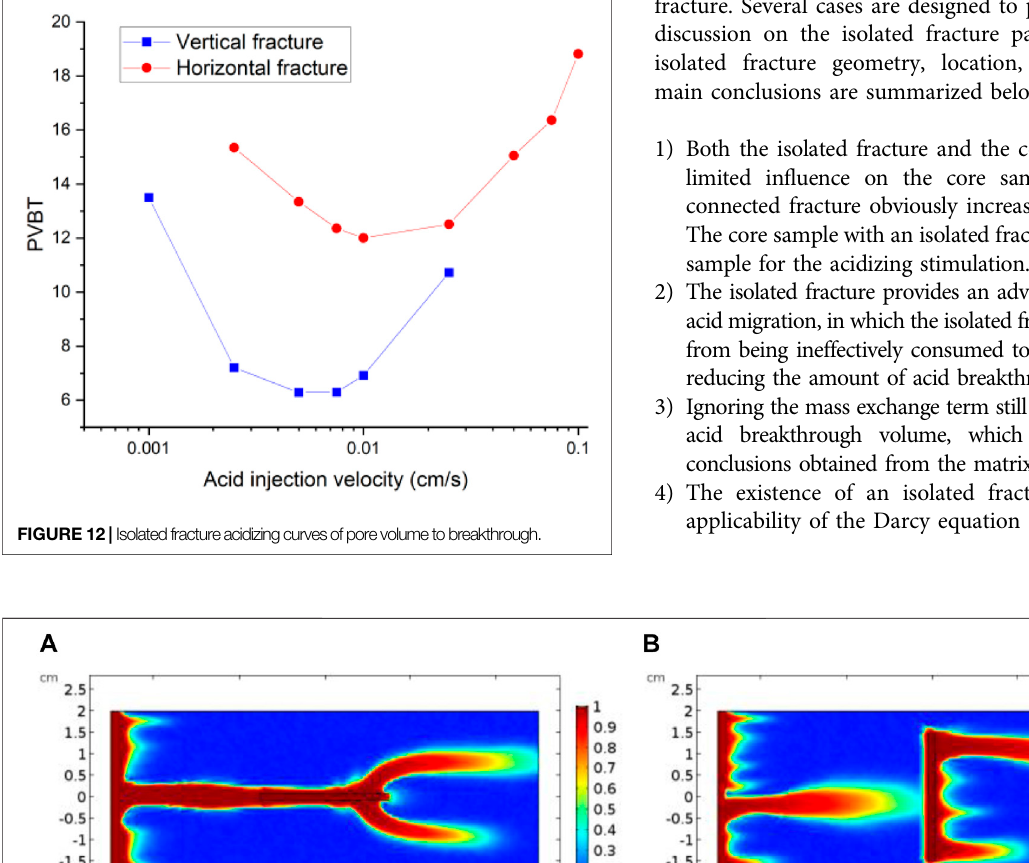
Frontiers in Earth Science |